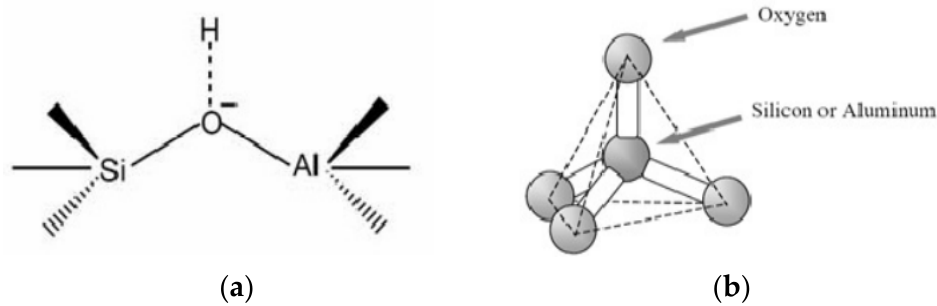
Figure 20. ( a ) Chemical structure of zeolites; ( b ) schematic of the building unit of zeolite structure. Repro-duced from Ref. [132].